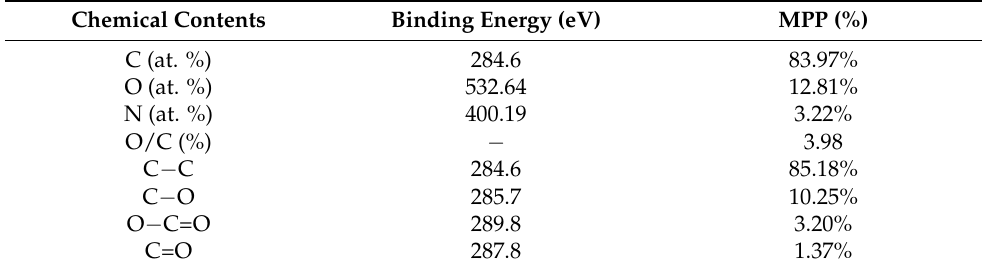
Table 1. Chemical contents and functional groups of C1s on